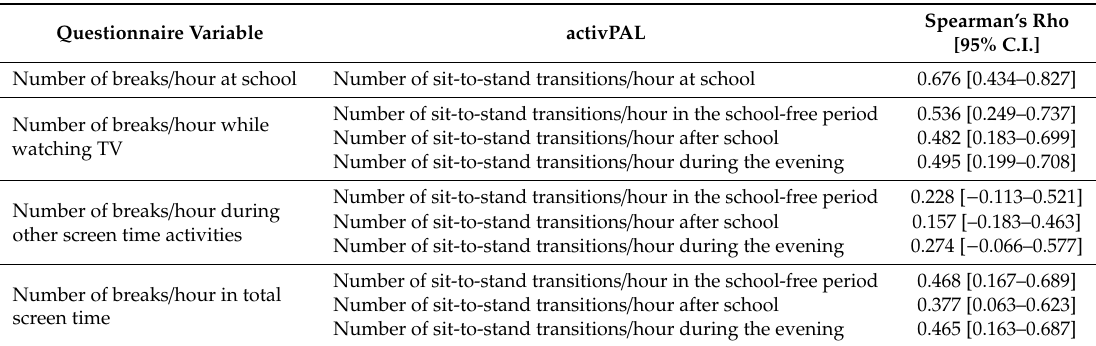
Table 3. Spearman’s Rho as indicator of concurrent validity of self-reported breaking up against activPAL sit-to-stand